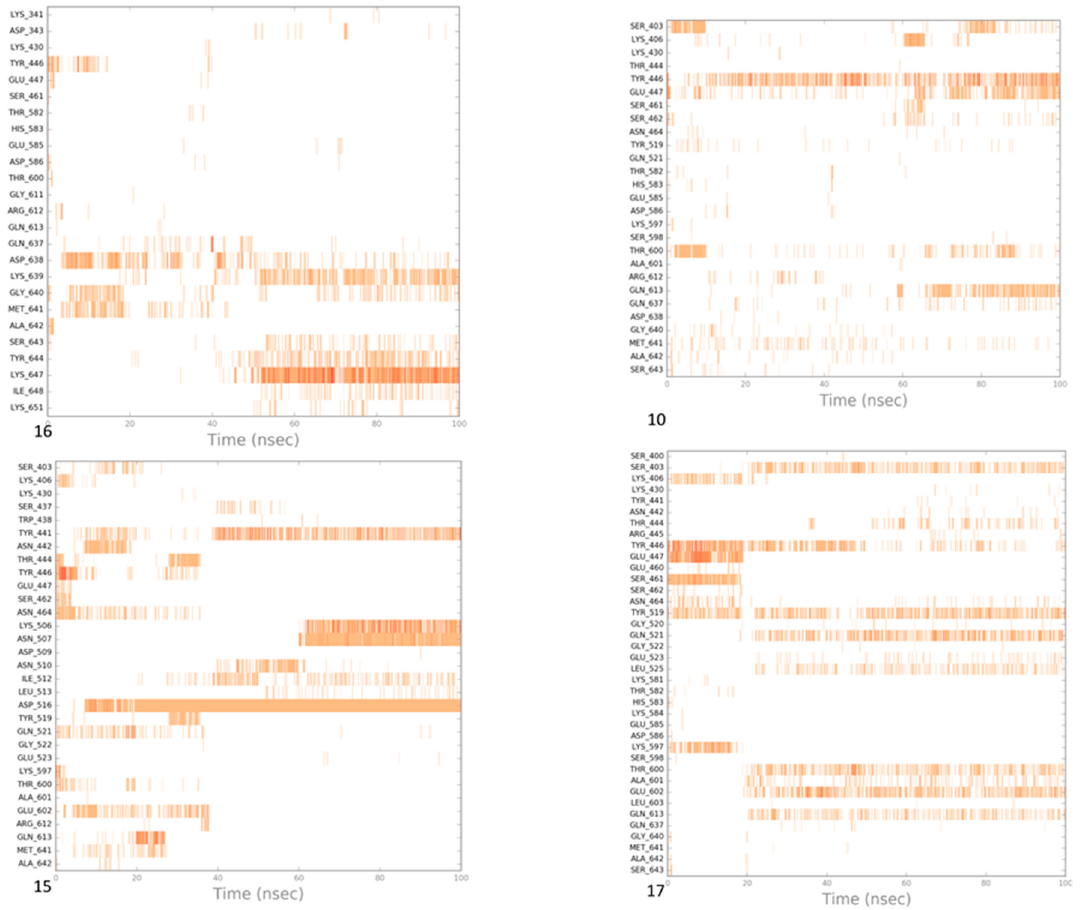
Figure 8. Ligand–protein interaction diagrams obtained for the PBP2a active site during molecular dynamic simulations for compounds 16 , 10 , 15 and 17 .